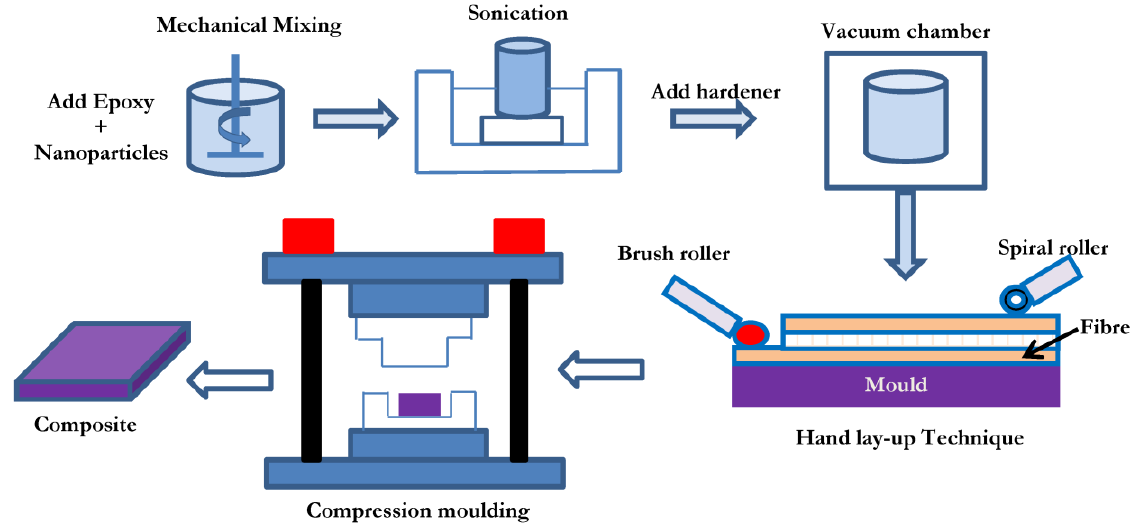
Figure 1. Laminated nanocomposite preparation process cycle.